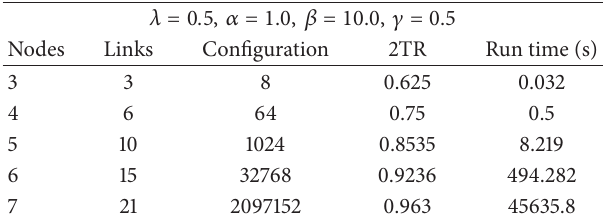
Table 2: Enumeration result of